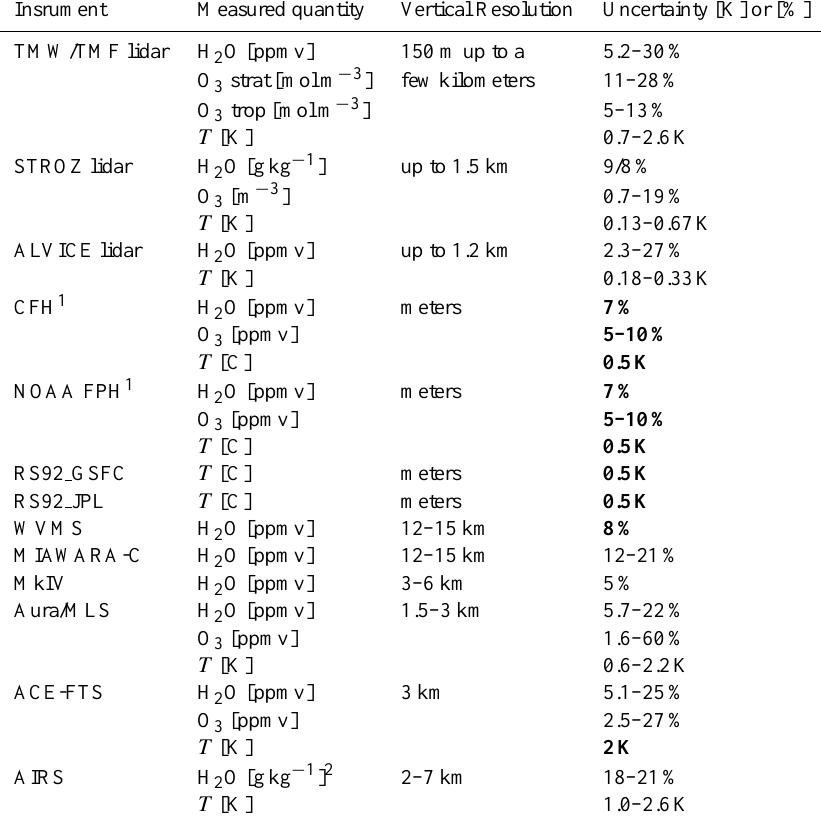
Table 2. Summary of vertical resolutions und total uncertainties of coincident measurements. The total uncertainties are derived by averaging over all provided error profiles of a single type within 10-km altitude bins, after having transformed the original provided measured quantity and its error into K or volume mixing ratio. The range of these mean errors over all altitude bins is given in the table. Uncertainties not provided in the data files but taken from references cited in the text are given in bold